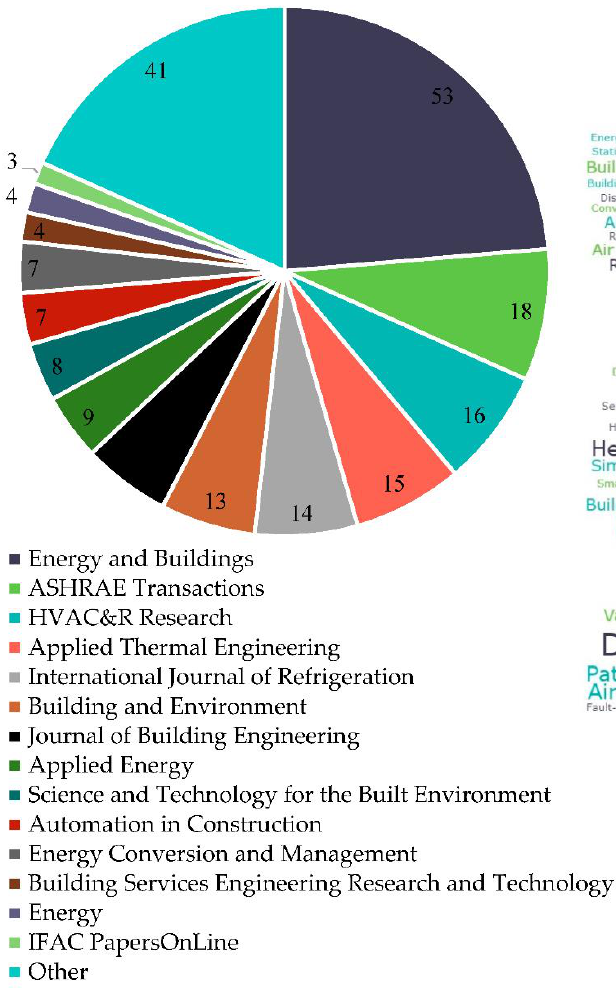
Figure 6. ( Left ) Top 35 journals that published the reviewed articles. The journals containing two or fewer published articles were not listed in this figure. ( Right ) Most commonly used keywords in the reviewed articles; an increased font size indicates that it was used more times. The 405 keywords used only once were excluded from this figure. Table 5. The defined EST groups, the corresponding building systems, and